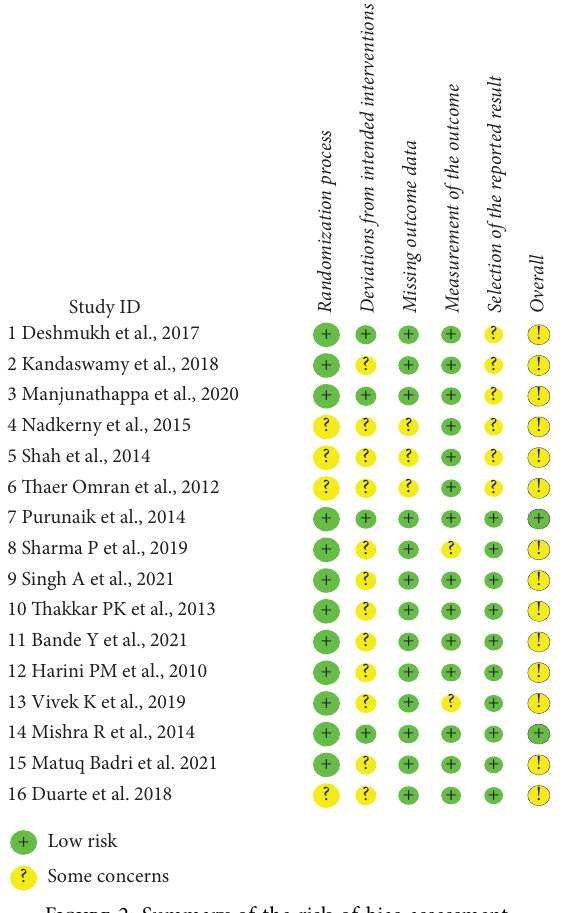
Figure 2: Summary of the risk-of-bias assessment. Table 2: Results of the publication bias. Outcomes Funnel